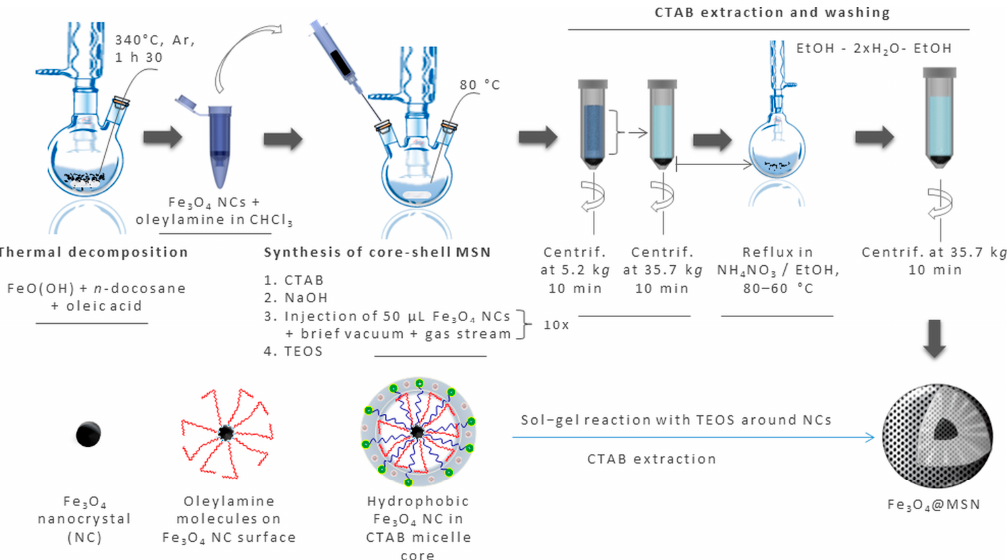
Figure 1. Schematic representation of the synthesis of bare magnetic mesoporous silica nanoparticles (Fe 3 O 4 @MSN). Firstly, Fe 3 O 4 nanocrystals (NC) are obtained by thermal decomposition of FeO(OH).